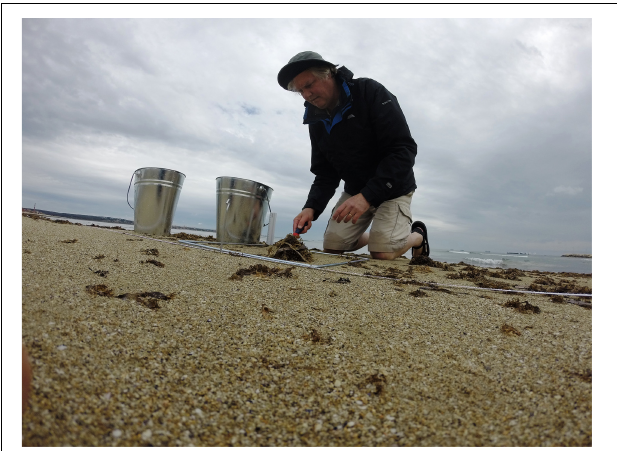
FIGURE 5 | Collecting samples at research site (J. Calcutt